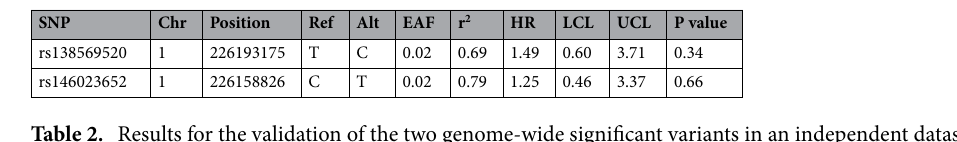
Table 2. Results for the validation of the two genome-wide significant variants in an independent dataset of breast cancer patients with metastatic primary breast cancer at diagnosis. ALT alternate, REF reference, EAF effect allele frequency, HR hazard rate, LCL lower control limit, UCL upper control limit, r 2 imputation